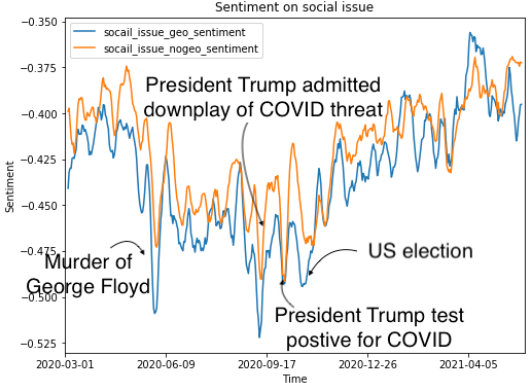
Figure 6. Sentiments towards social issues.